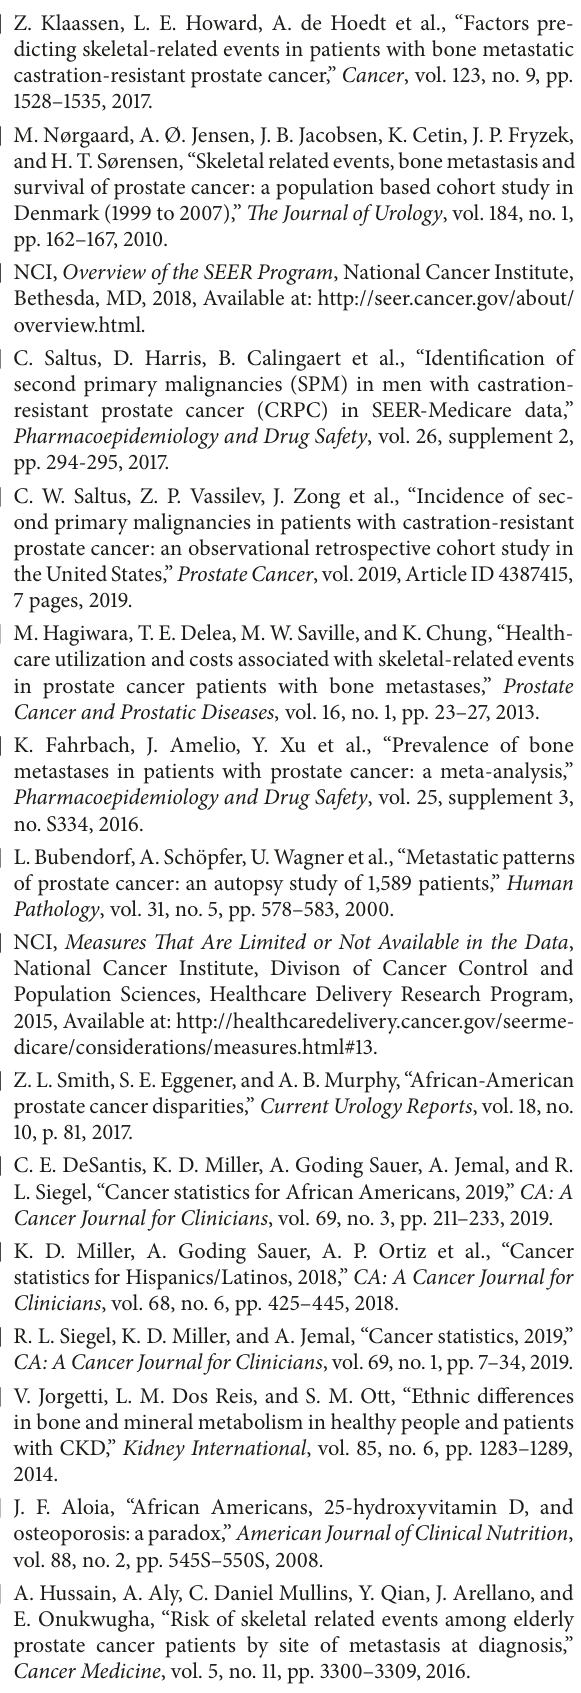
Table S-1. ICD-9 diagnosis codes used to identify frac- ture in Medicare claims. Table S-2. Codes used to identify other skeletal-related events (radiation therapy, surgery on bone, and spinal cord compression) in Medicare